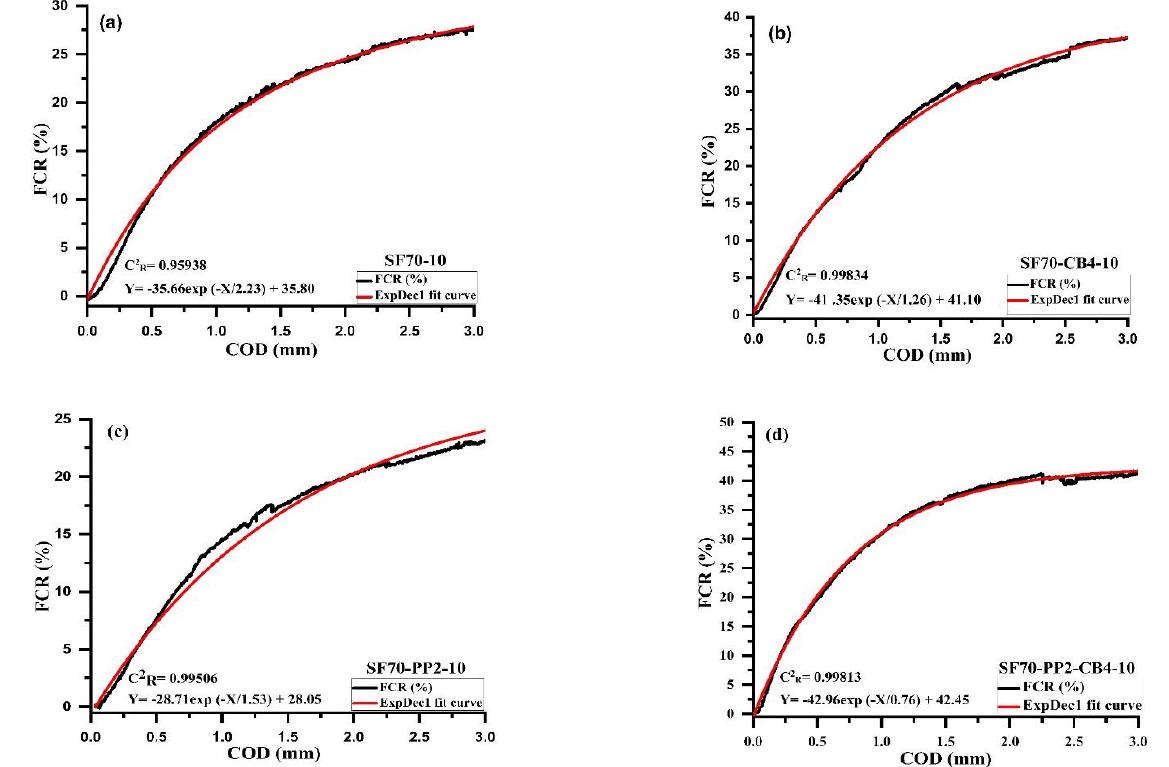
Figure 6. Relationship between FCR and COD of ( a ) SF70-10 ( b ) SF70-CB4-10 ( c ) SF70-PP2-10 ( d ) SF70-PP2-CB4-10. For the specimens containing 20 mm aggregates with SF70-20 steel fiber content, the values of FCR 3 increased with the addition of carbon black. However, these values were not higher than those of 10 mm aggregate specimens. The values of FCR 3 for all 20 mm size specimens increased by 26.5%, 35%, 22.50% and 16.50%, respectively. The FCR 3 values increased by 39.62% and 35.84%, respectively for SF70-CB4-20 and SF70-PP2-CB4-20 when compared to SF70-20. As compared to 10 mm aggregate specimens (SF70-10, SF70-CB4- 10, SF70-PP2-10 and SF70-PP2-CB4-10), the values of 20 mm aggregates (SF70-20, SF70- CB4-20, SF70-PP2-20, SF70-PP2-CB4-20) decreased by 4.5%, 10.32%, 4.12% and 61%, re- spectively. In both aggregate sizes, the FCR 3 increment was observed, with an addition of carbon black in diphasic and triphasic admixtures. The NCB particles were devoted to different fibers in the form of grapes [51]. The nanocarbon black with fibers acted similarly to a bunch of grapes, which improved the effective conductive path.